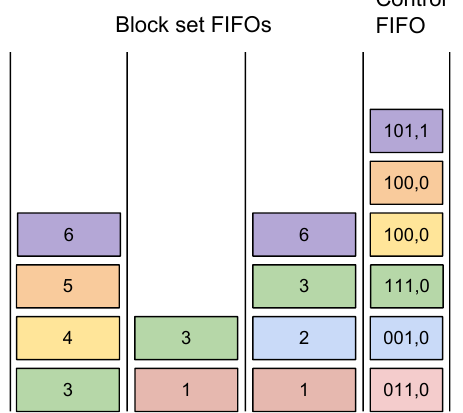
Figure 13. Memory organization for block set